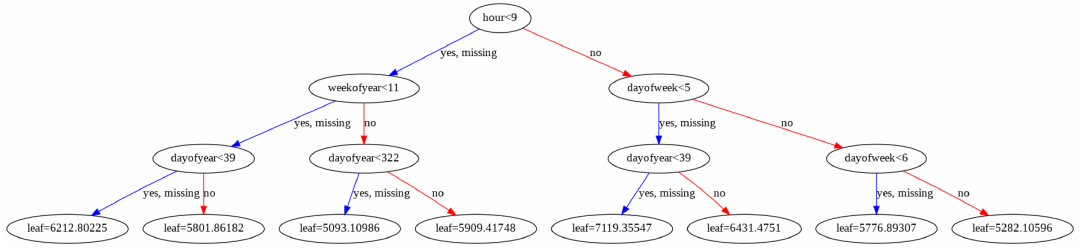
Figure 19. Boosting